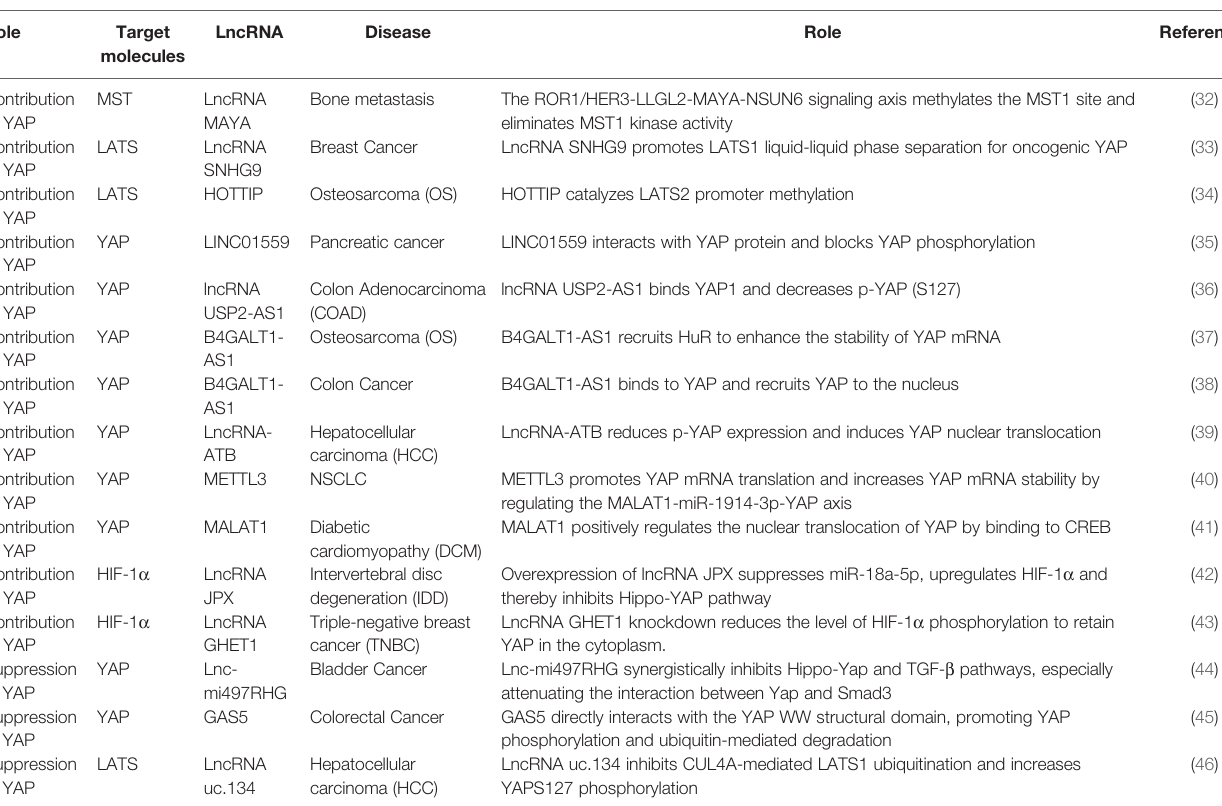
TABLE 2 | Regulation of HIPPO-YAP pathway by